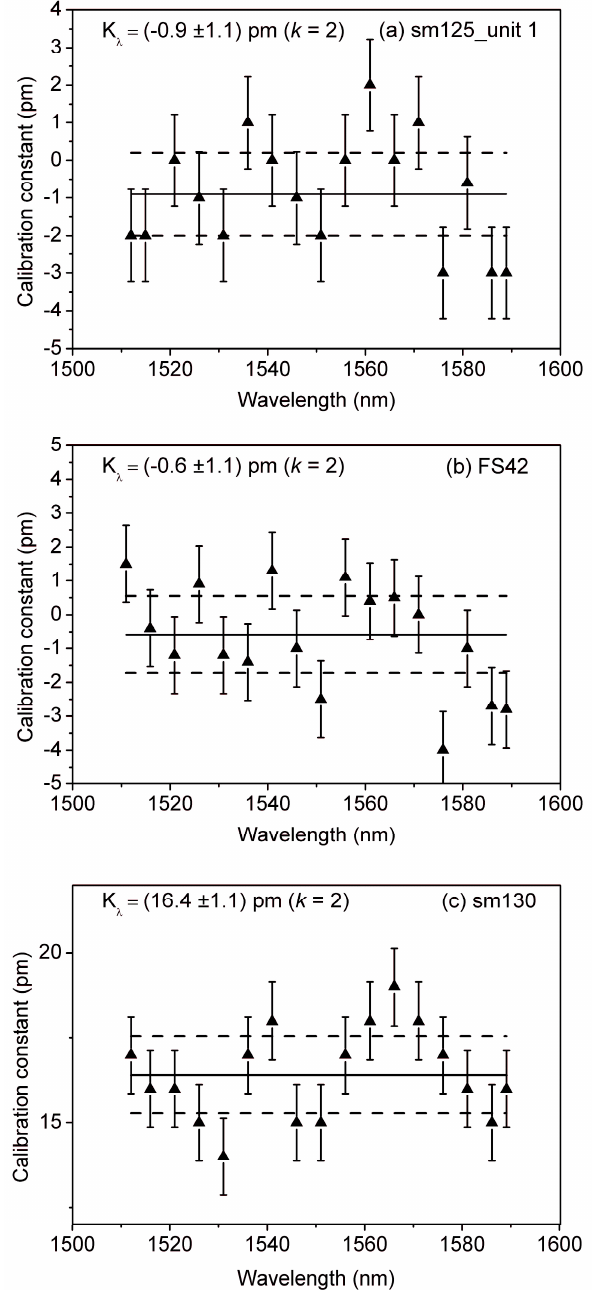
Figure 5. Correction constants with wavelength-dependent uncertainties for the devices under test, as determined by the first calibration method: ( a ) sm125-500; ( b ) FS42; ( c ) sm130-700. The mean correction constant (solid line) and expanded uncertainty ( k = 2, dashed line) are also depicted.